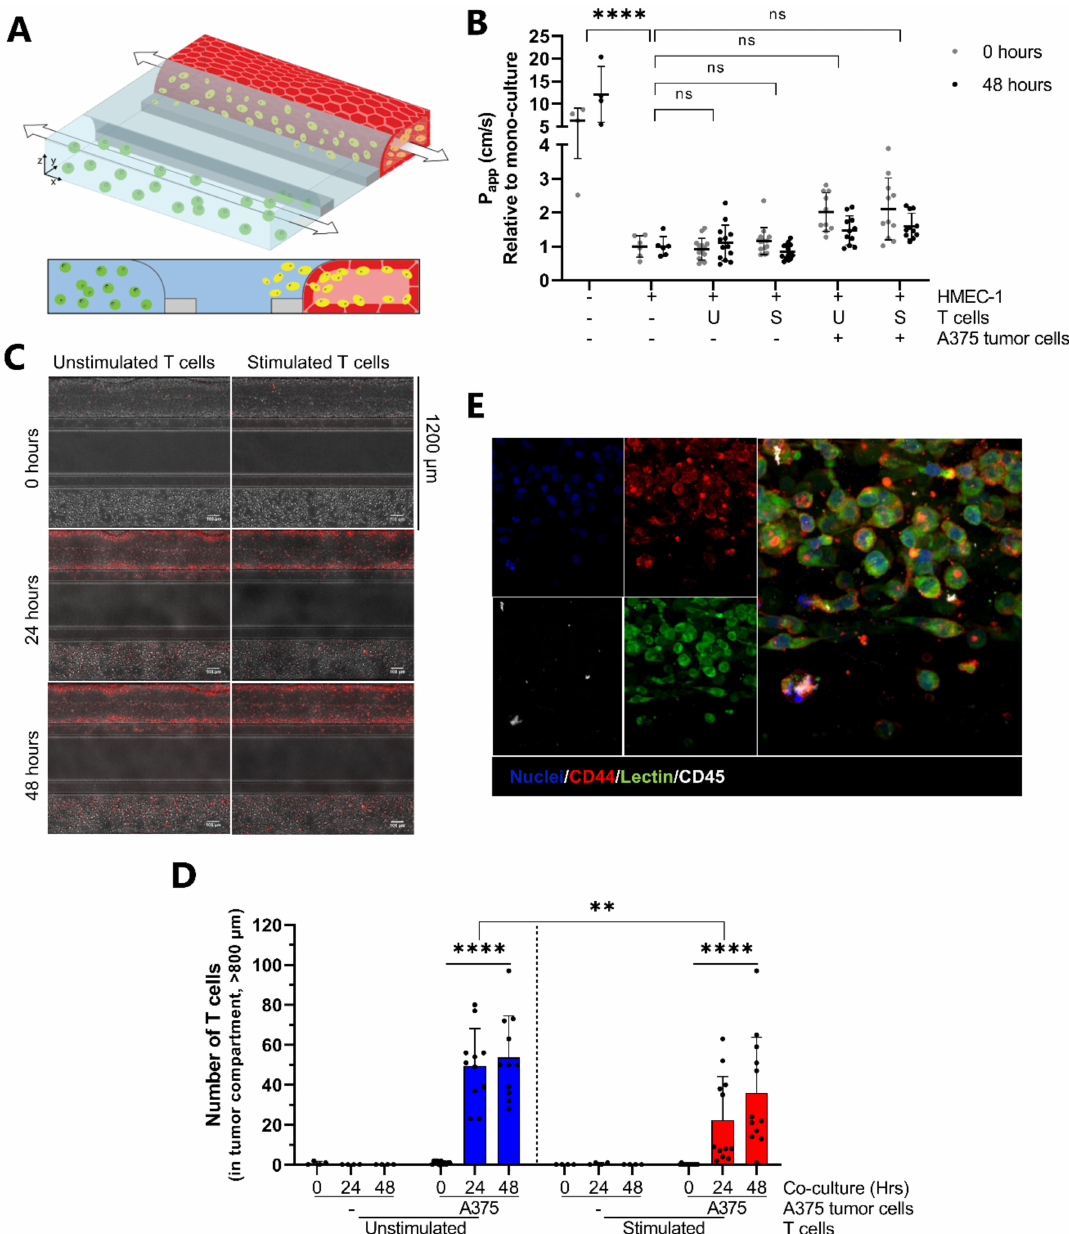
Figure 5. The migration of T cells is affected by the presence of A375 dermal melanoma cells. ( A ) A375 tumor cells (green) embedded in a second ECM gel are patterned in the bottom channel prior to the addition of T cells (yellow) to the apical side of the HMEC-1 vessel. ( B ) The presence of A375 tumor cells slightly affects barrier integrity of the HMEC-1 vessel. Apparent permeability (Papp) values are normalized against Papp values of chips containing mono-cultured HMEC-1 vessels and an empty ECM gel in the bottom channel. Shown are mean ± SD, and data points represent individual chips ( N = 2, n = 2–6). Statistical analysis was performed on non-normalized data. Data were log transformed and analyzed using mixed-effects models. Statistical analyses indicated significant differences between chips containing HMEC-1 vessels and empty chips (**** p < 0.0001) and no significant differences (ns) between mono-cultured or co-cultured vessels. ( C ) Composite max intensity projections of live cultures consisting of HMEC-1 endothelial cells perfused with either unstimulated or stimulated fluorescently labelled T cells (red, CellTracker Orange CMRA) after 0, 24 and 48 h of co-culture. The bottom channel of the microfluidic chip contains ECM-embedded A375 dermal melanoma cells. Scale bar = 100 µ m. ( D ) Unstimulated and stimulated T cells